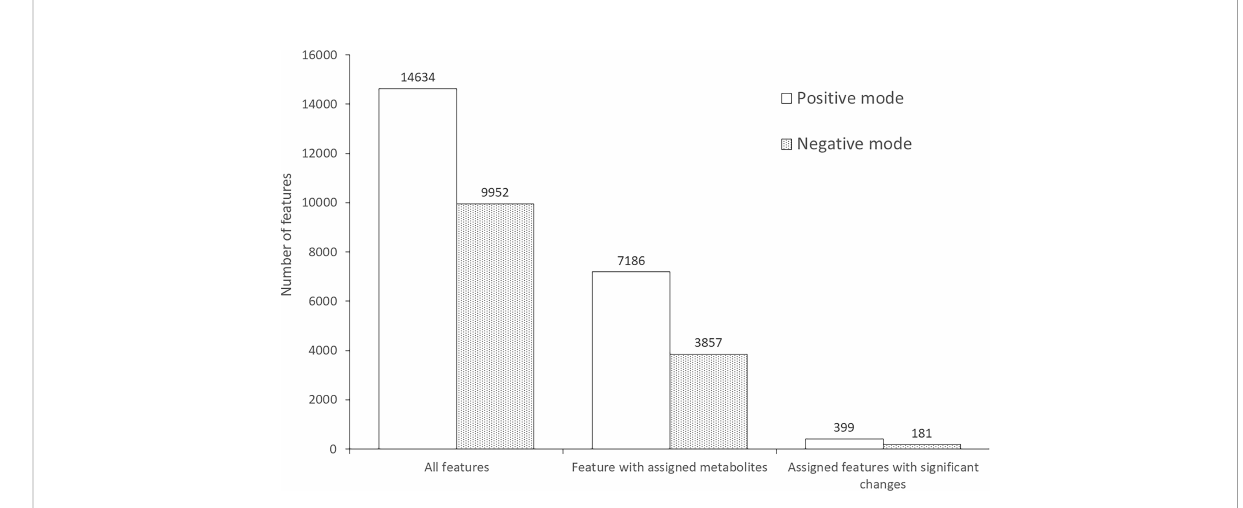
FIGURE 1 Number of features identi fi ed from metabolomic analysis of mouse serum after S. mekongi